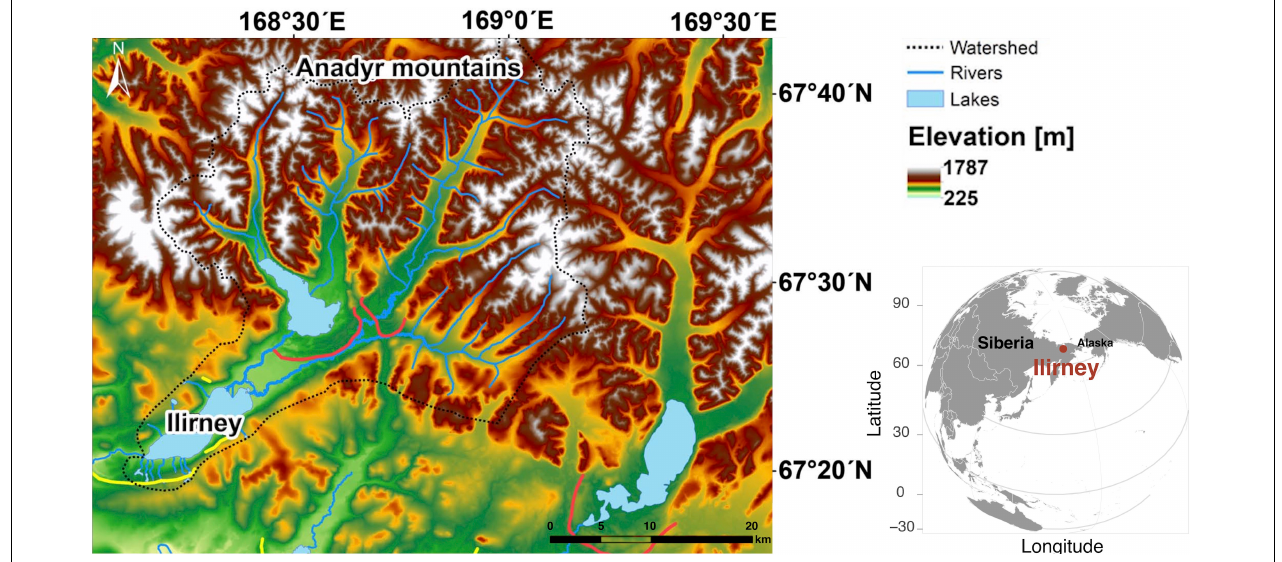
FIGURE 1 | Overview of Ilirney area in the Russian Arctic and the study location. The figure is adapted from Vyse et al.